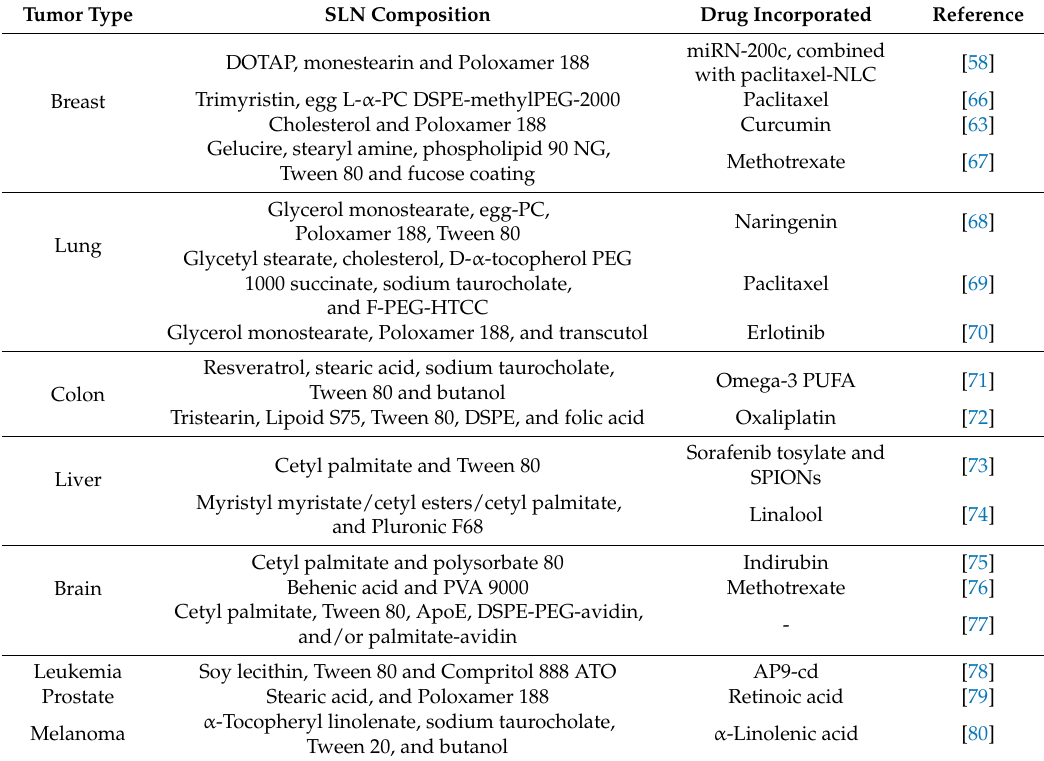
Table 1. Use of SLNs against different types of tumors. Summary of studies related to the use of SLNs to improve the action of anticancer drugs or agents. Studies applying SLNs against breast, lung, colon, and brain tumors are